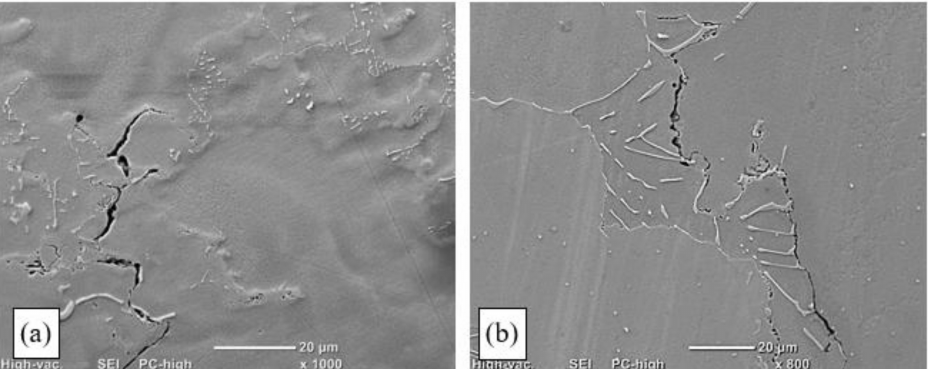
Figure 10. Structure of a remelted area on an Inconel 713C precision casting, obtained by TIG welding with no filler material (E l = 0.38 kJ/mm): ( a ) crack in the partially melted zone; ( b ) cracks along dendrite boundaries in the area of “Chinese script”